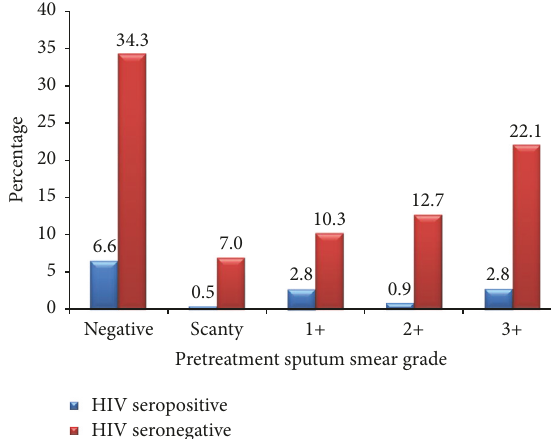
Figure 3: TB/HIV coinfection . Negative: no Acid-Fast Bacilli (AFB) seen in at least 100 fields ; scanty (sc): 1–9 AFB found in 100 fields ; (1+): 10–99 AFB found in 100 fields ; (2+): 1–10 AFB found per field